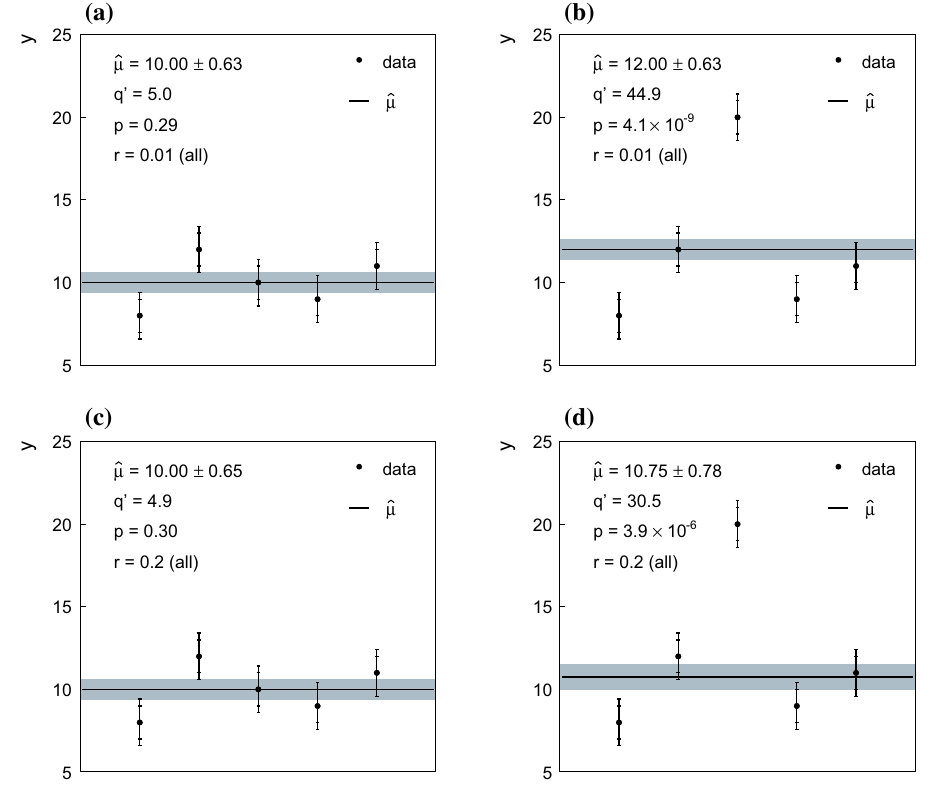
point is at 20. In the top two plots, the r i parameters for all measurements are taken to be r i = 0 . 01, which is very close to what would be obtained with an ordinary least-squares